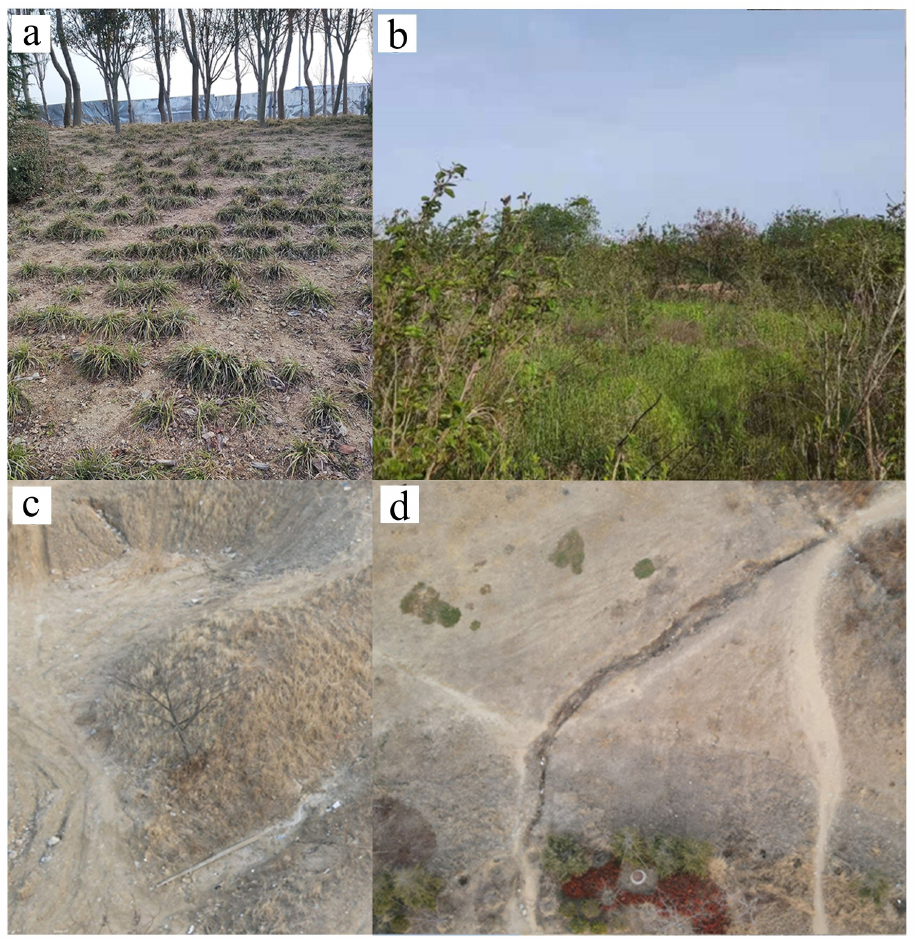
Figure 3. Soil erosion status in the south of Xuejiadao in 2022: ( a ) artificial understory grassland; ( b ) wild grassland; ( c ) abandoned landfills; and ( d ) wasteland erosion